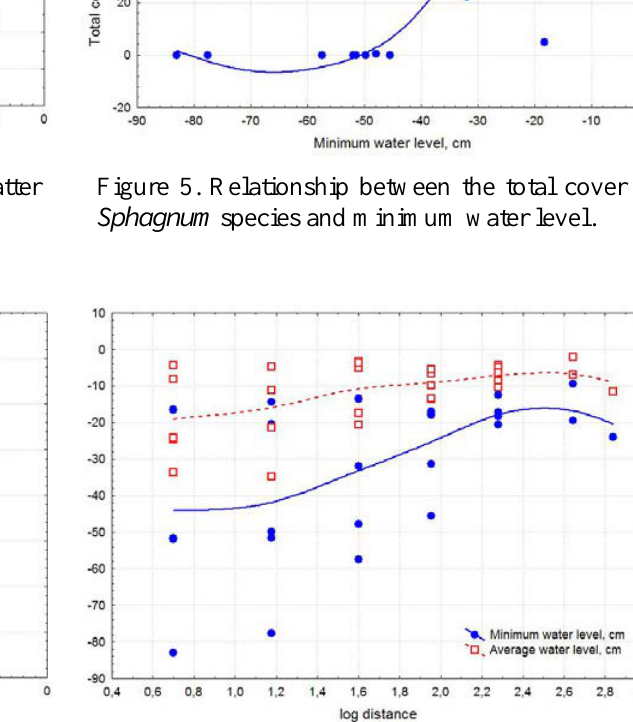
Figure 7. Relationships between the minimum and average water level, and log-distance from the cutoff ditch.